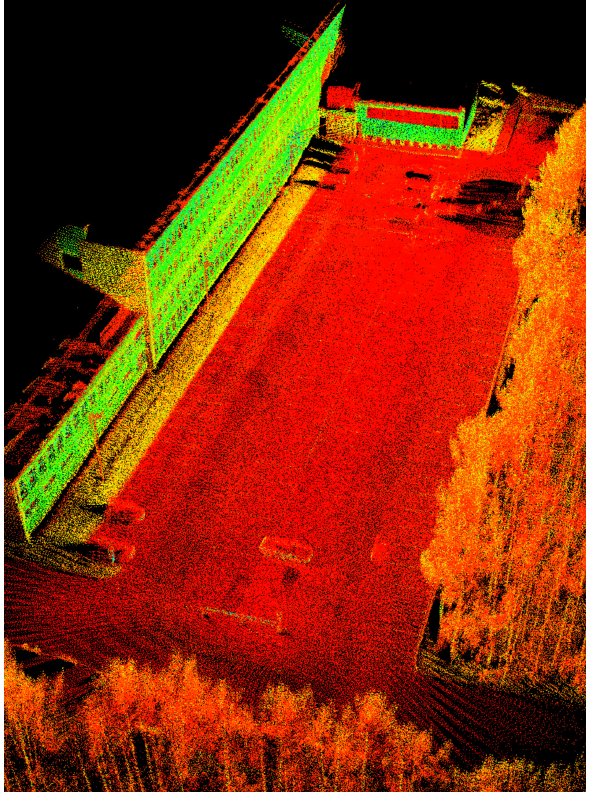
Figure 2. The placement of the VLP-16 and Spatial Dual sensors on the roof of a vehicle. 360° spherical camera Ladybug5 can be seen in the centre. The surveyed building façade in the background.